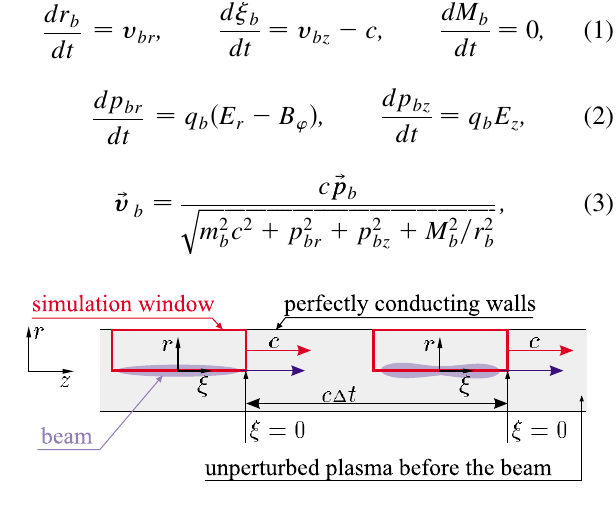
FIG. 1. (Color) Geometry of the